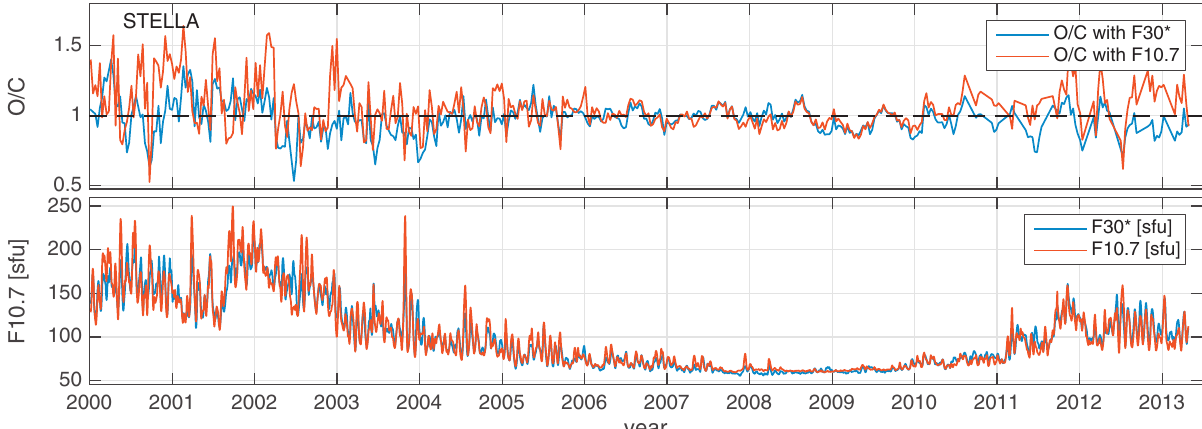
Fig. 9. 10-day averaged Stella density ratios (O/C) obtained with the F10.7 and F30* thermosphere models and 81-day mean F10.7 and F30*